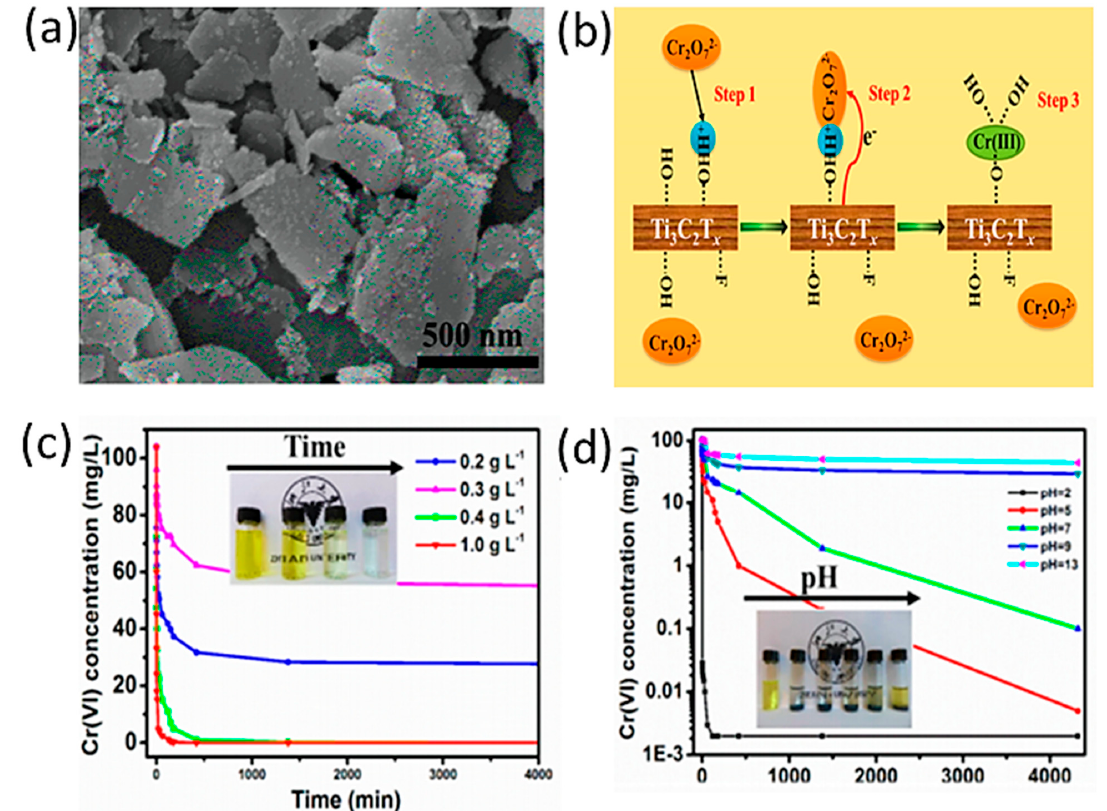
Figure 5. ( A ) SEM image of exfoliated Ti 3 C 2 T x nanosheets (HF 10%). ( B ) Mechanism of Cr(VI) removal by Ti 3 C 2 T x . ( C ) Effect of varying Ti 3 C 2 T x -10% nanosheets on Cr (VI) concentration (pH 5.0). ( D ) Effect of varying